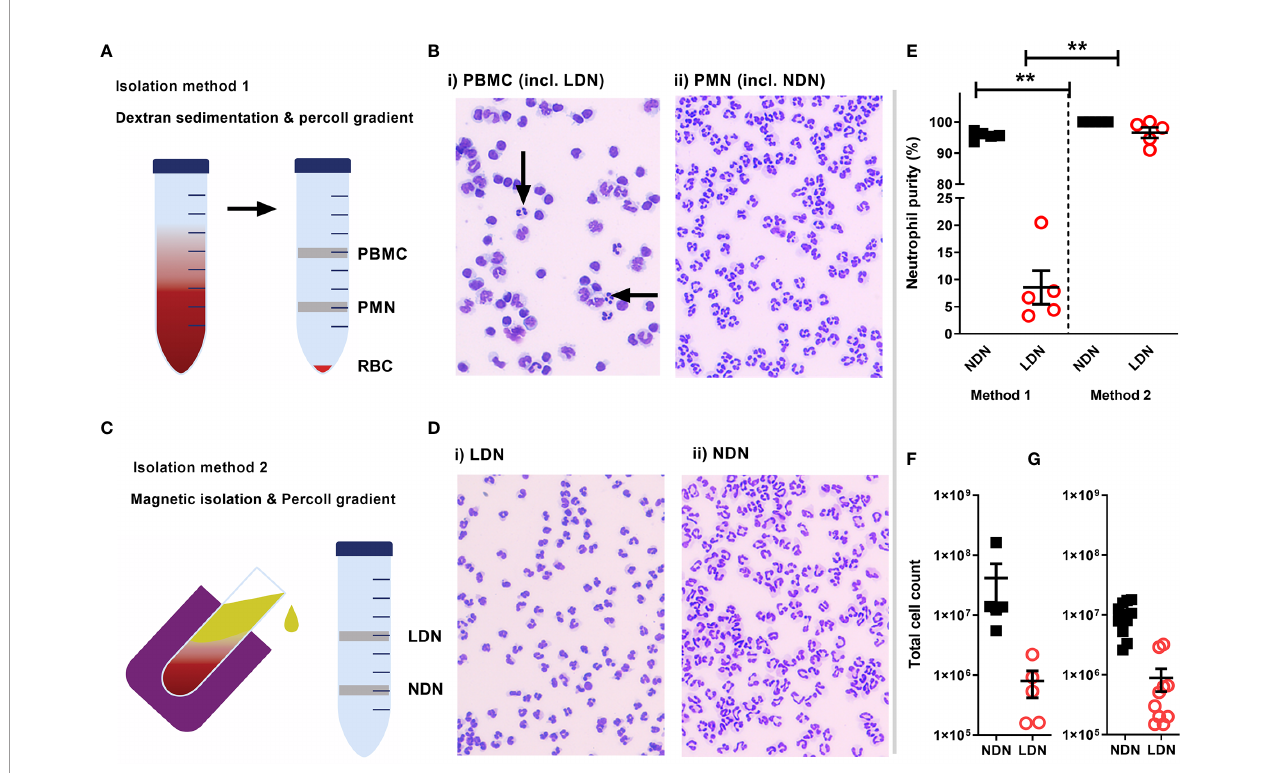
FIGURE 1 | Isolation of a high purity population of low density neutrophils from healthy donors (A) Overview of traditional isolation protocol PBMC, peripheral blood mononuclear cells PMN, polymorphonuclear cells; RBC, red blood cells. (B) Representative images of cells isolated by traditional protocol. Black arrows show neutrophils in PBMC layer. (C) Overview of magnetic, negative isolation protocol, LDN, low density neutrophils; NDN, normal density neutrophils. (D) Representative images of enriched LDNs and NDNs isolated by magnetic, negative selection protocol (E) Quanti fi cation of neutrophils isolated by each protocol, (N=5) (F) Total number of neutrophils (CD66b+ CD16+) identi fi ed within the PBMC population isolated from 12 mls blood by fl ow cytometry (N=5) (G) Total number of neutrophils isolated from 12mls blood by magnetic isolation (N=10). Statistical testing with two tailed unpaired T test where **p ≤ 0.01 Data shows means ± SEM error